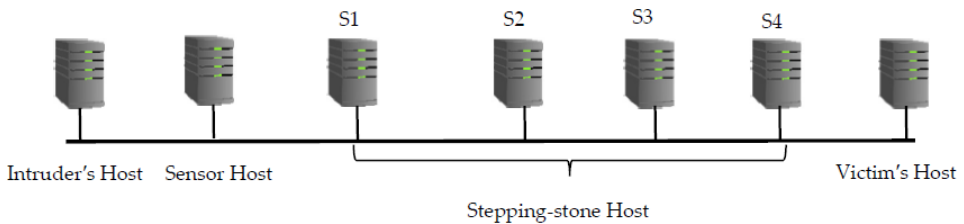
Figure 4. A connection chain of length five from the sensor host to the victim’s host.